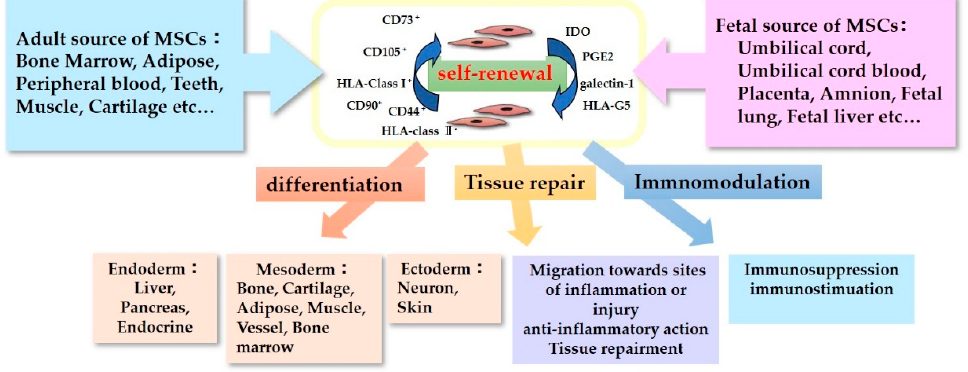
Figure 1. Characteristics of Mesenchymal stromal/stem cells (MSCs).